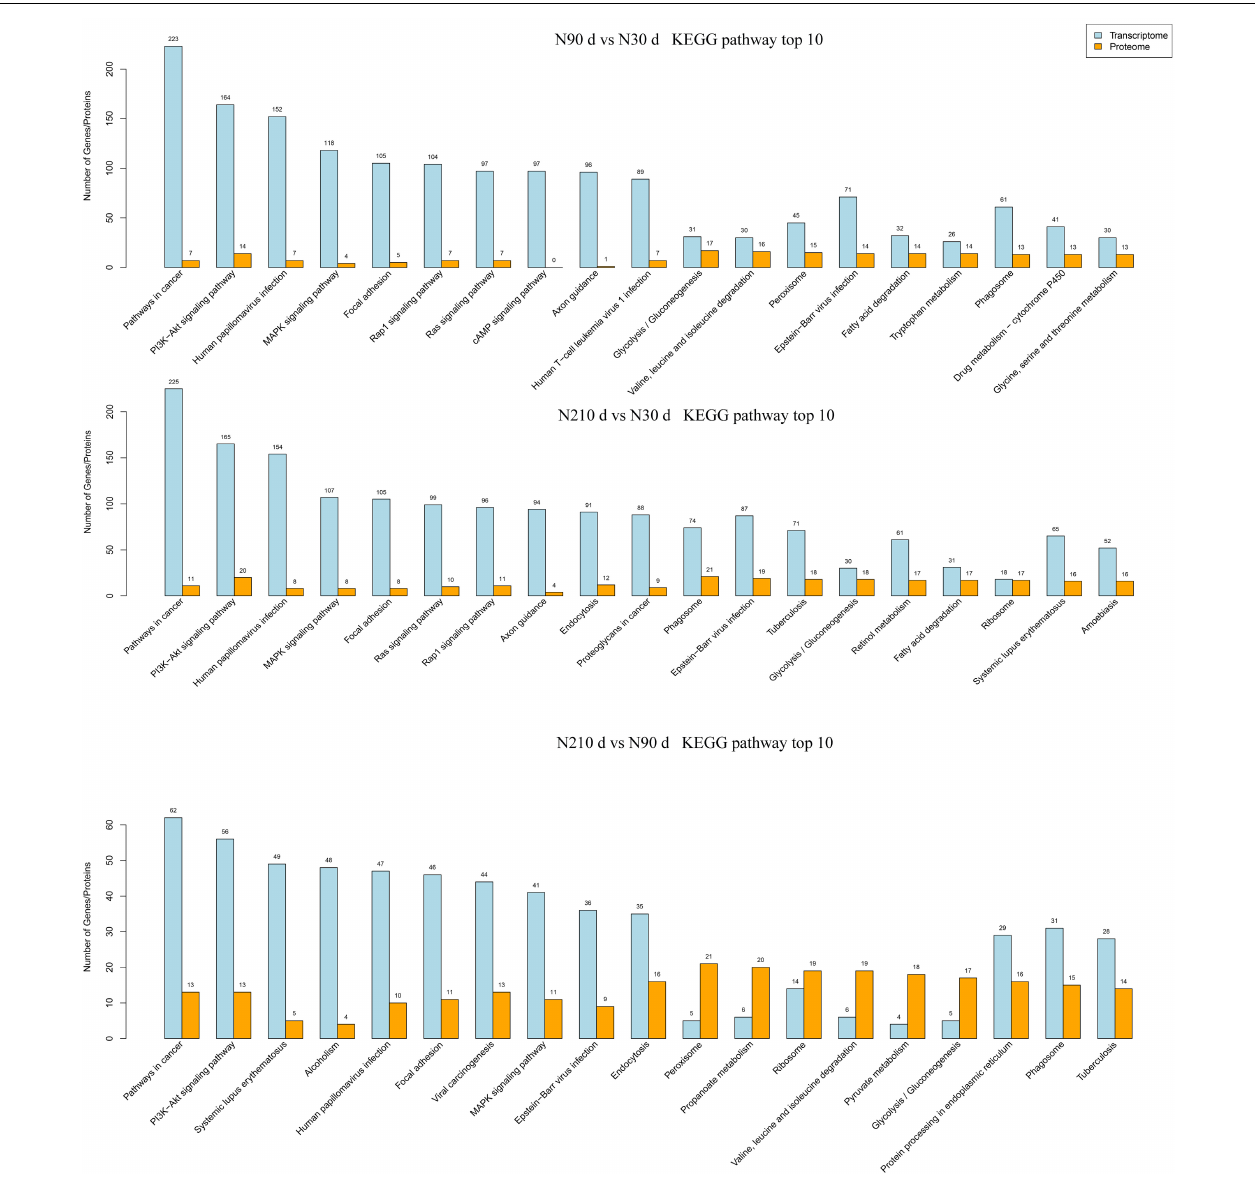
FIGURE 5 | The number of DEG and DEP enriched in KEGG pathway was analyzed by combined transcriptome and protein analysis.